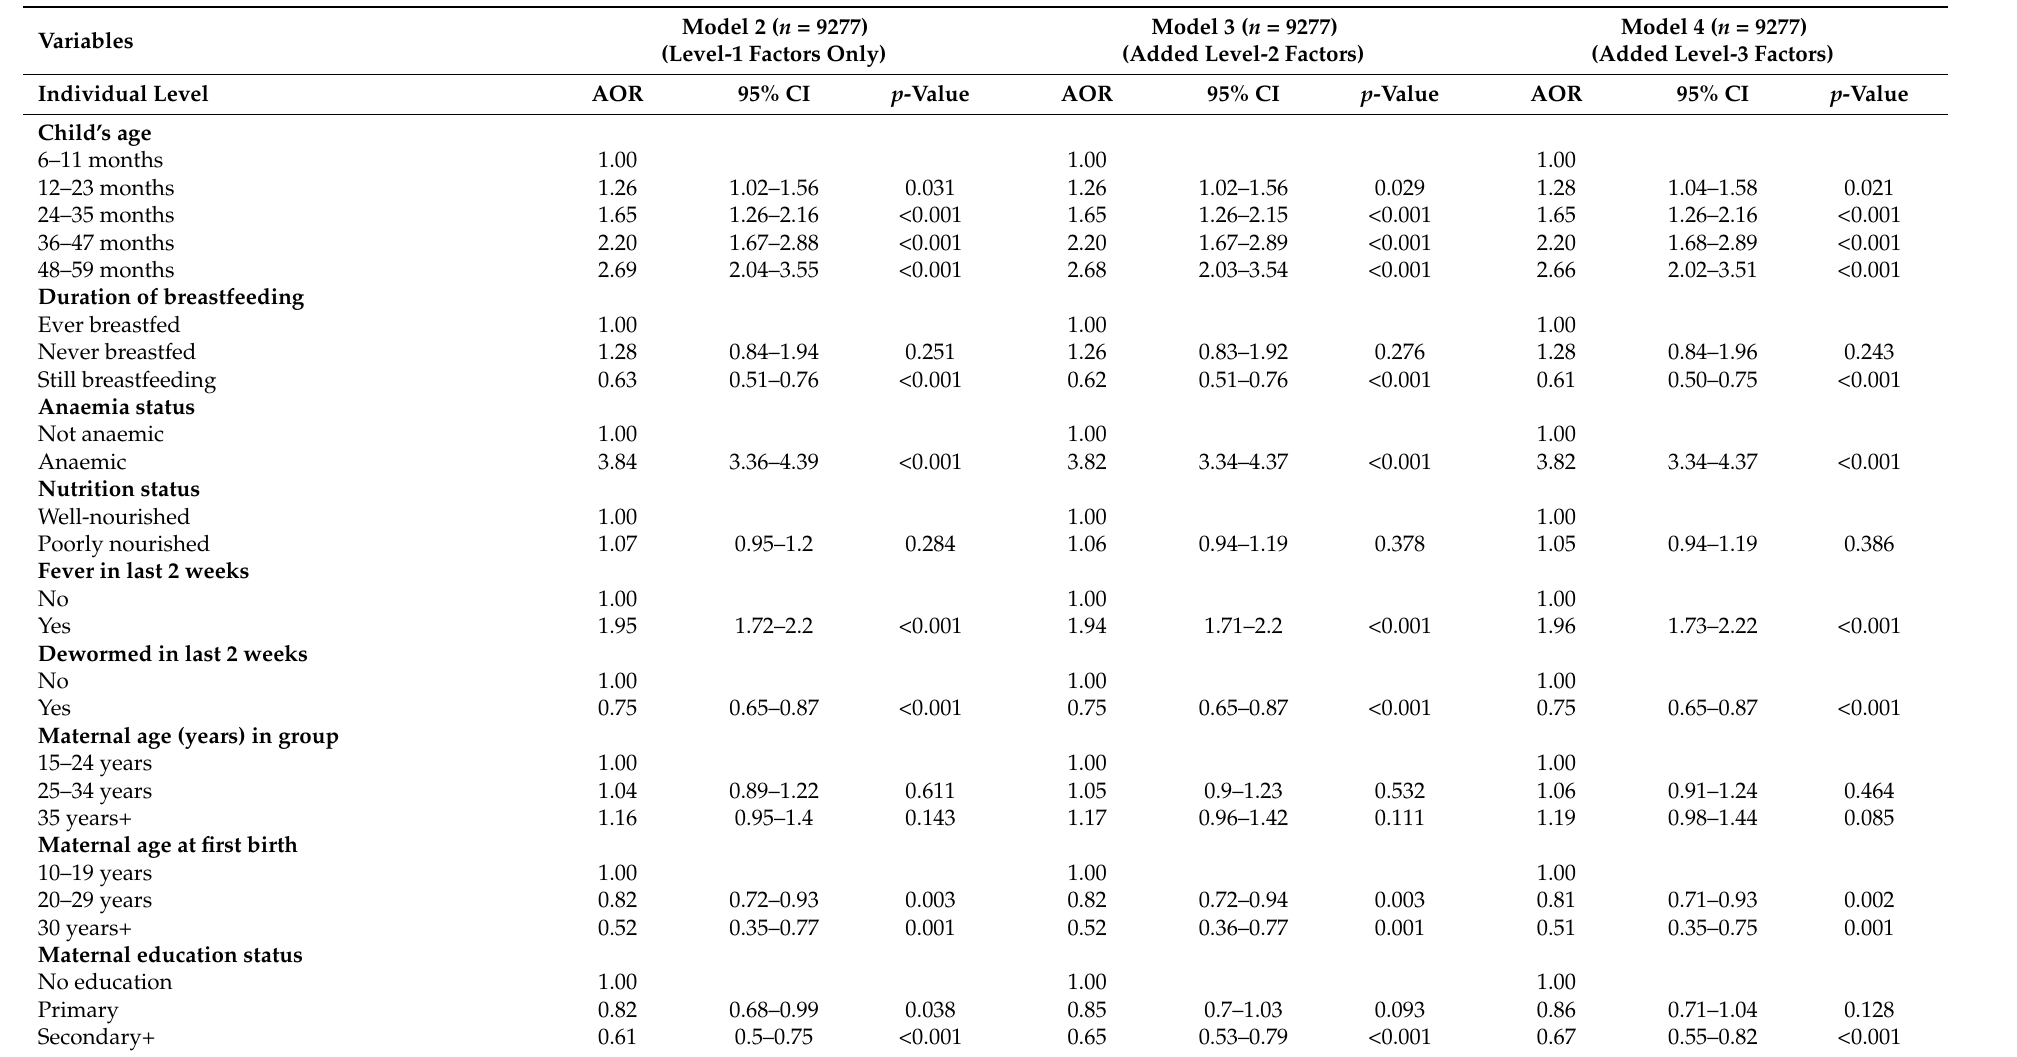
Table 2. Multilevel multivariate models of predictors of malaria with adjusted odds ratios (AOR) among children 6–59 months in